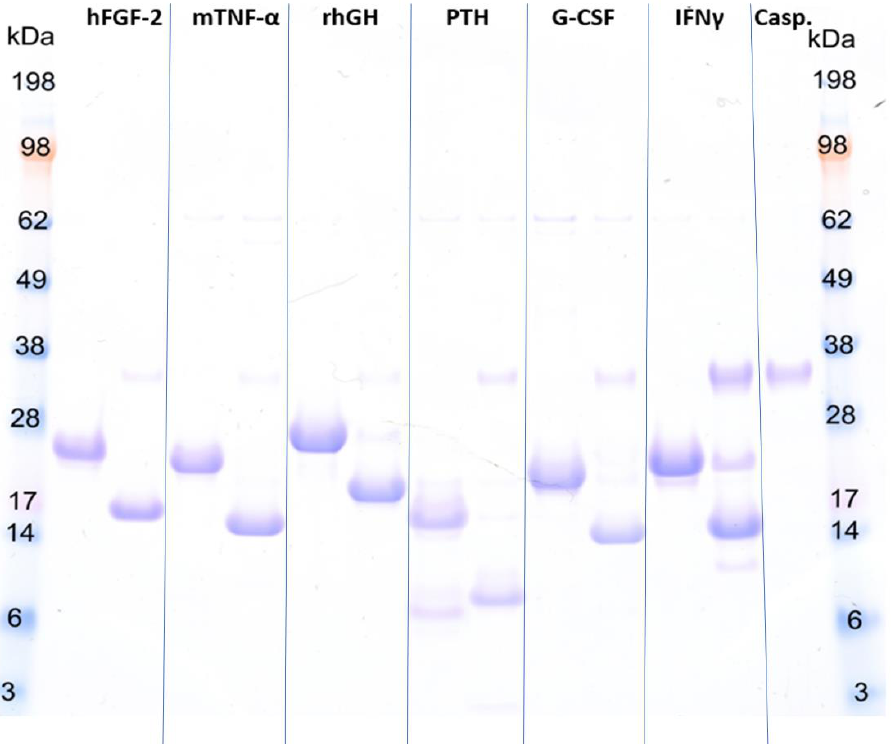
Figure 3. SDS Page of the enzymatic cleavage of produced fusion proteins. Protein identities are denoted at the top of the gel. For each model protein, two lanes are reserved. In the first lane, the uncleaved protein is shown while the cleaved protein can be seen in the second lane. In the lane titled Casp. the pure caspase-2 used for proteolytic cleavage is shown. Cleavage conditions were optimized for each protein. The molar ratio of enzyme to substrate was either 1:100 (hFGF-2, mTNF- α , rhGH, PTH, G-CSF) or 1:10 (INF γ ). The cleavage reaction was terminated when either full substrate cleavage was achieved or a reaction time of 24 h was reached. Detailed cleavage conditions are given in Section 3.5.